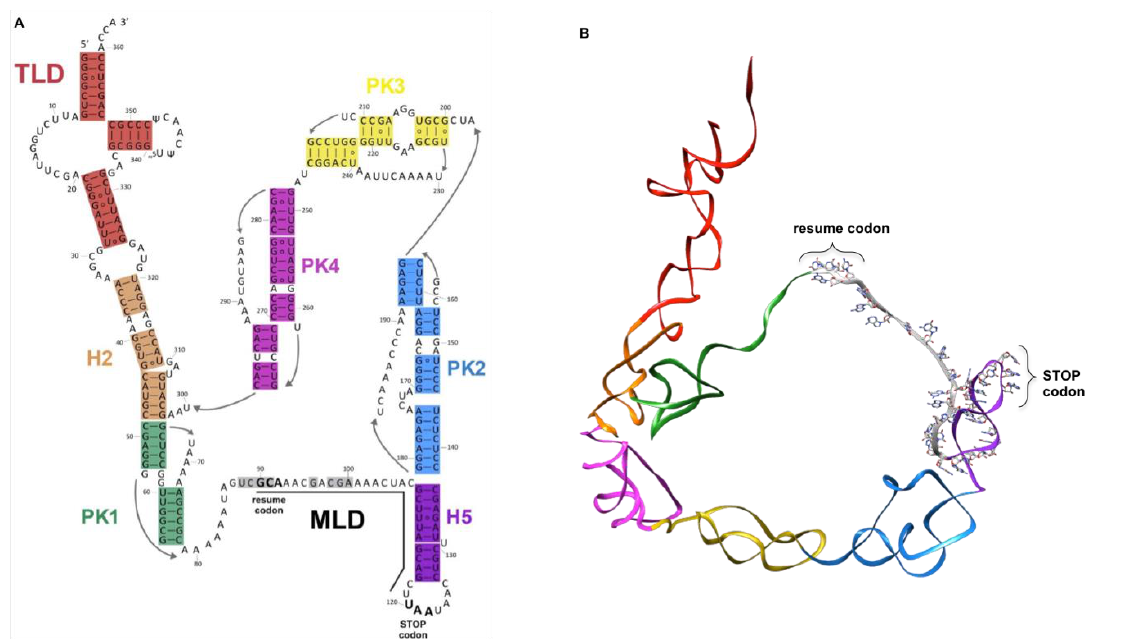
Figure 1. tmRNA. ( A ) Organization of the secondary structure of Escherichia coli tmRNA. The internal open reading frame is underlined. ( B ) 3D structure of the E. coli tmRNA molecule. In both panels, the tRNA-like domain (TLD, red) is followed by helix H2 (orange). The pseudoknot ring is composed of PK1 (dark green), PK2 (steel blue), PK3 (yellow), PK4 (magenta), helix H5 (purple), and the mRNA-like domain (MLD, grey). The resume and stop codons are indicated.